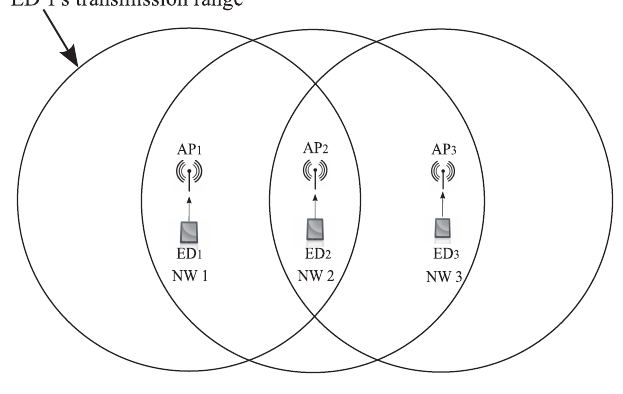
Figure 1. Scenario with inter-network interference.